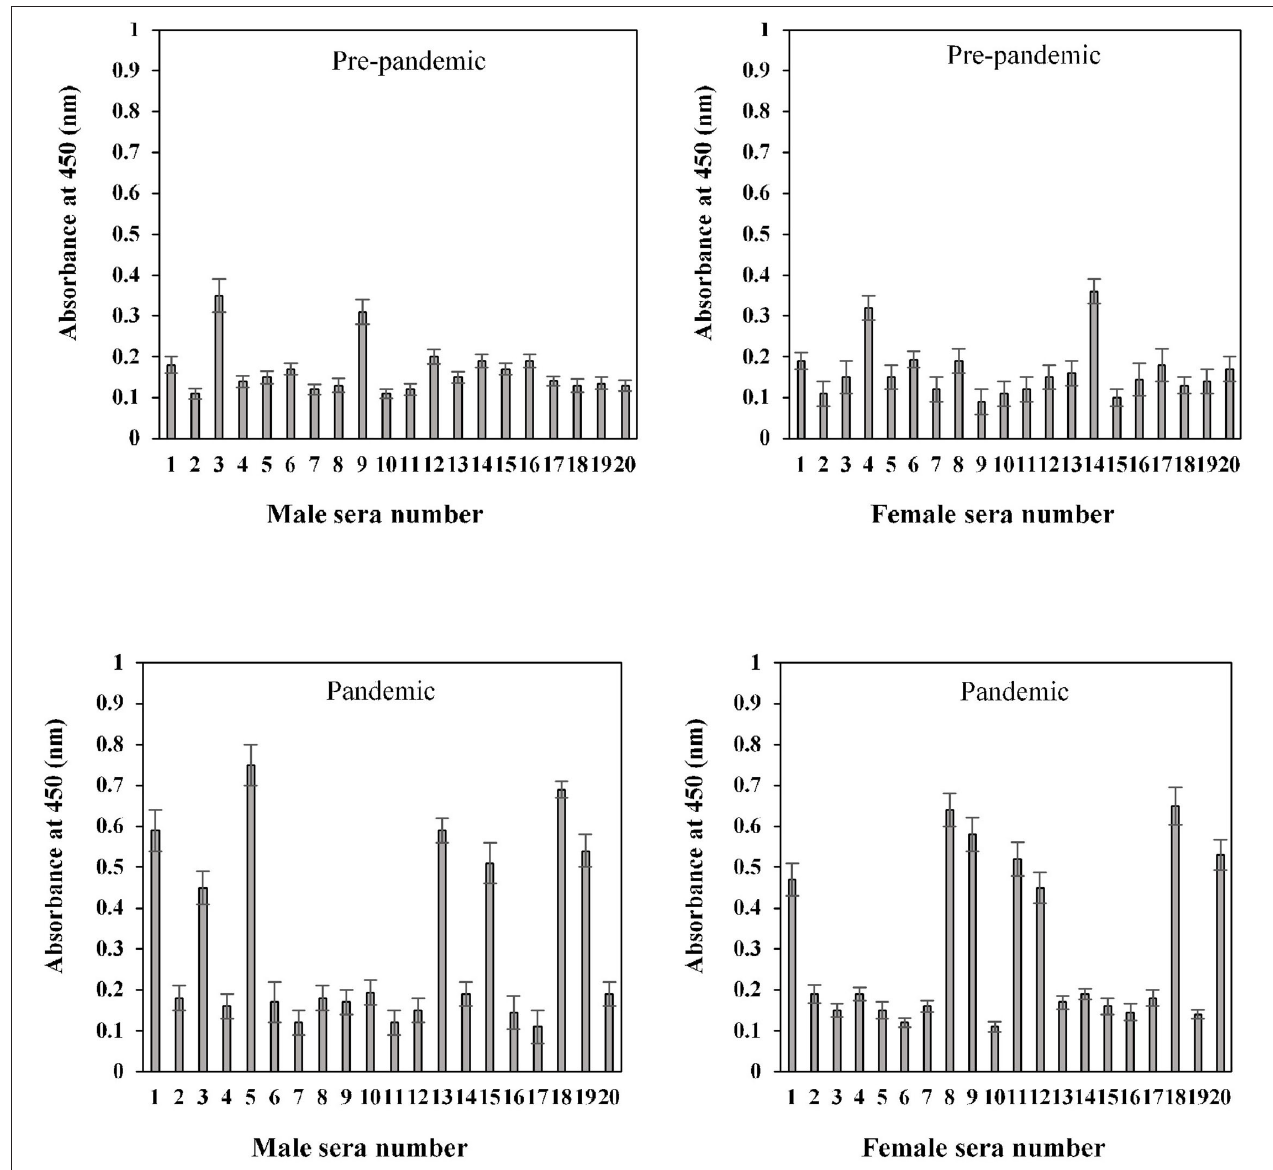
FIGURE 7 | Indirect binding ELISA of pre-pandemic samples and samples collected during the pandemic from men and women aged 20–40 years. ELISA plates were coated with an antigen concentration of 2 µ g/ml. Each sample was run in triplicate under similar conditions.